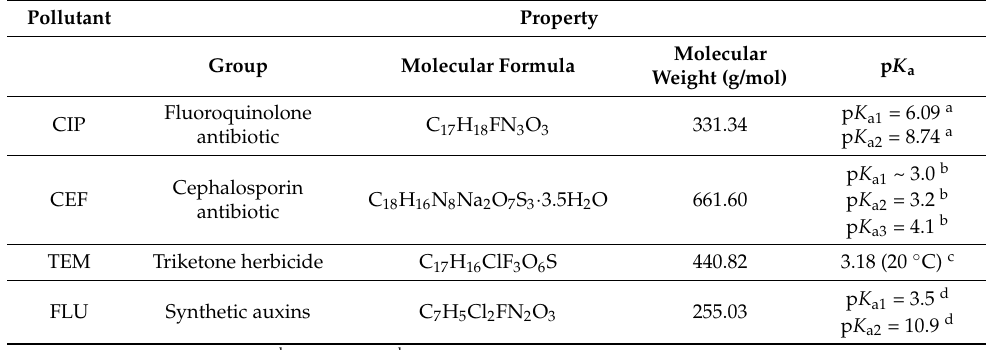
Table 1. Major properties of investigated emerging